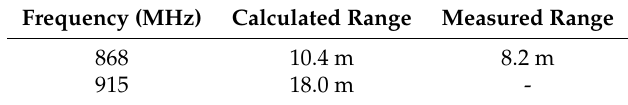
Table 1. Calculated and measured indoor read-range of the proposed flexible RFID